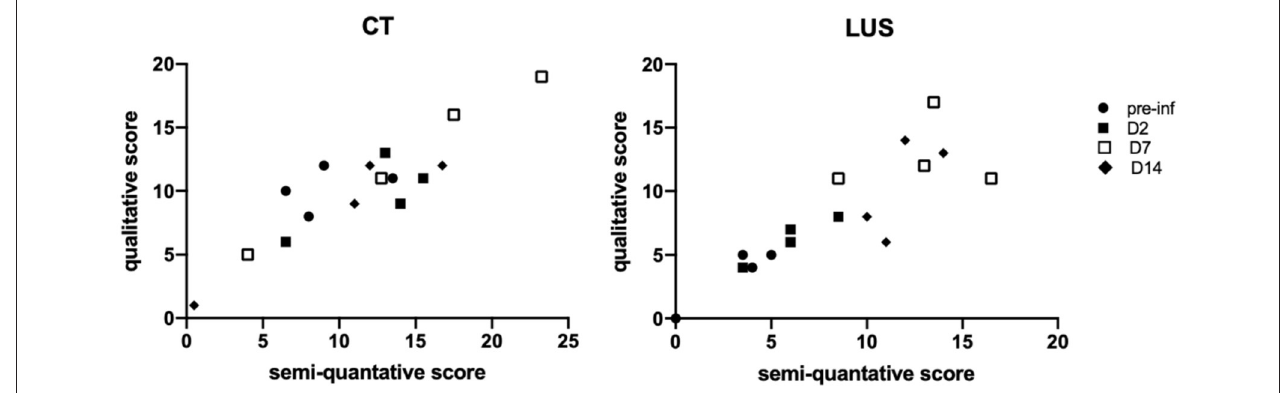
FIGURE 3 | Correlation graphs between qualitative and semi-quantitative scores are shown per modality in which the days are marked with different symbols. The correlation for CT is r = 0.7778, p = 0.0006 and for LUS r = 0.8913, p < 0.0001.